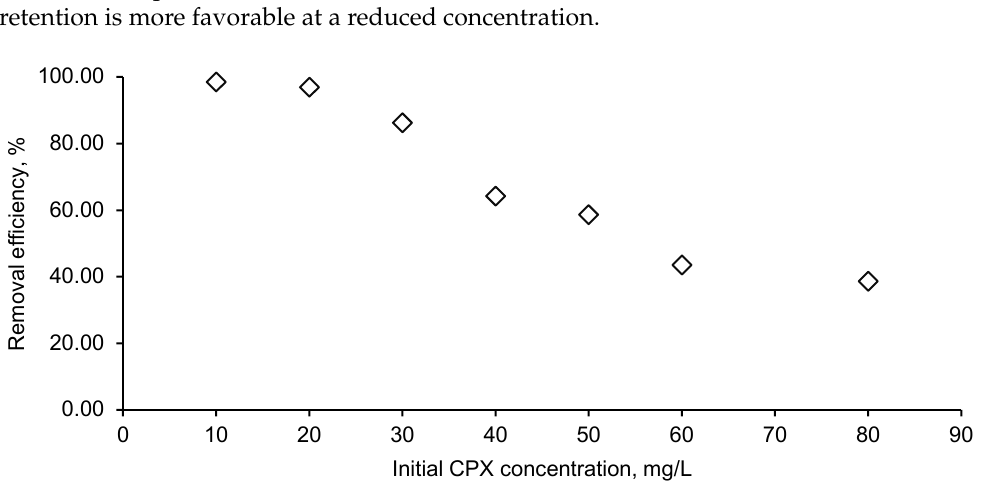
Figure 9. Initial CPX influence on the removal efficiency (CPX solution volume: 25 mL; CPX initial solution pH: 4; biosorbent dose: 1 g/L).